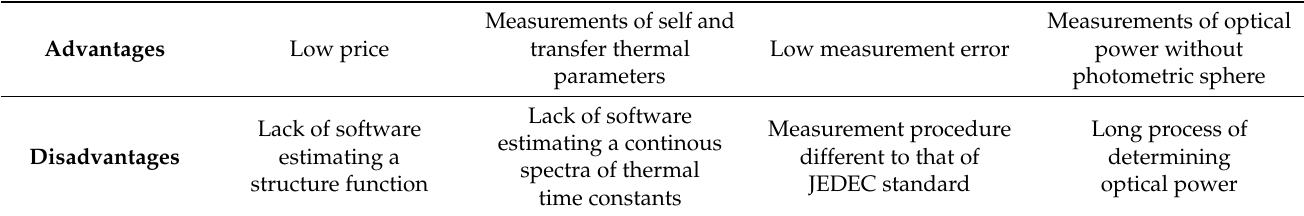
Table 1. Advantages and disadvantages of the custom set-up.